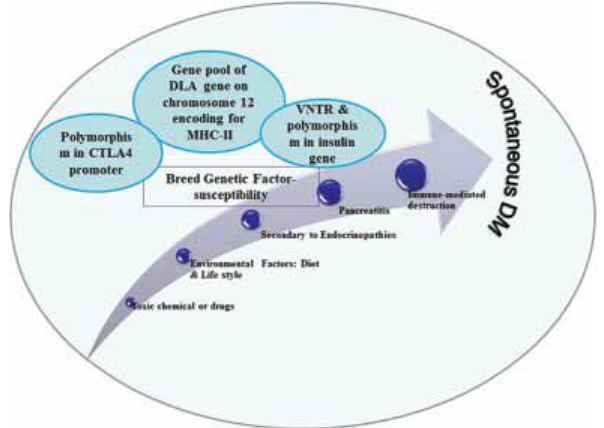
Figure-1: Schematic diagram showing possible factors responsible for spontaneous diabetes mellitus, CLLA4: Cytotoxic T-lymphocyte antigen 4, DLA: Dog leucocyte antigen, VNTR: Variable number of tandem